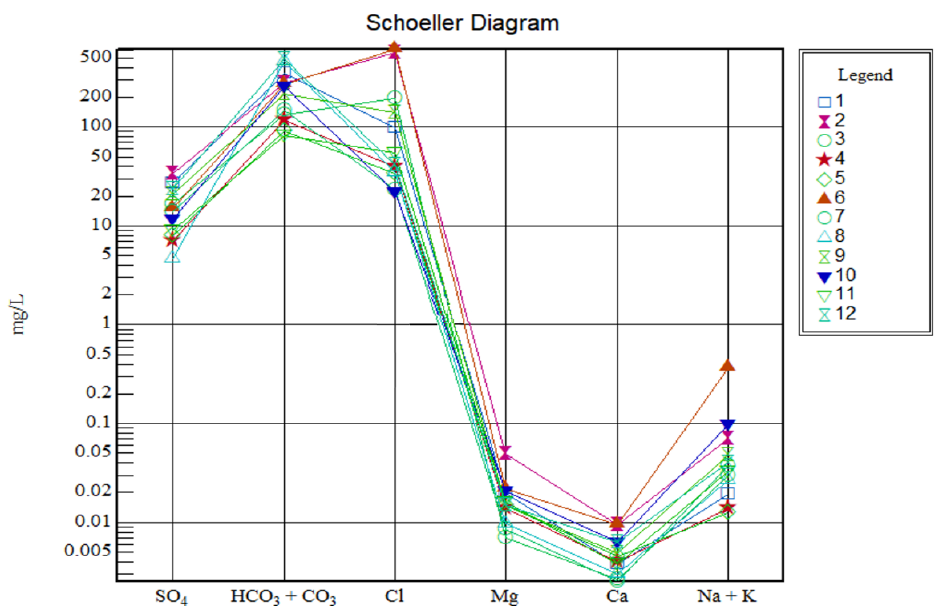
Figure 5. Schoeller diagrams for all water samples (1–12).